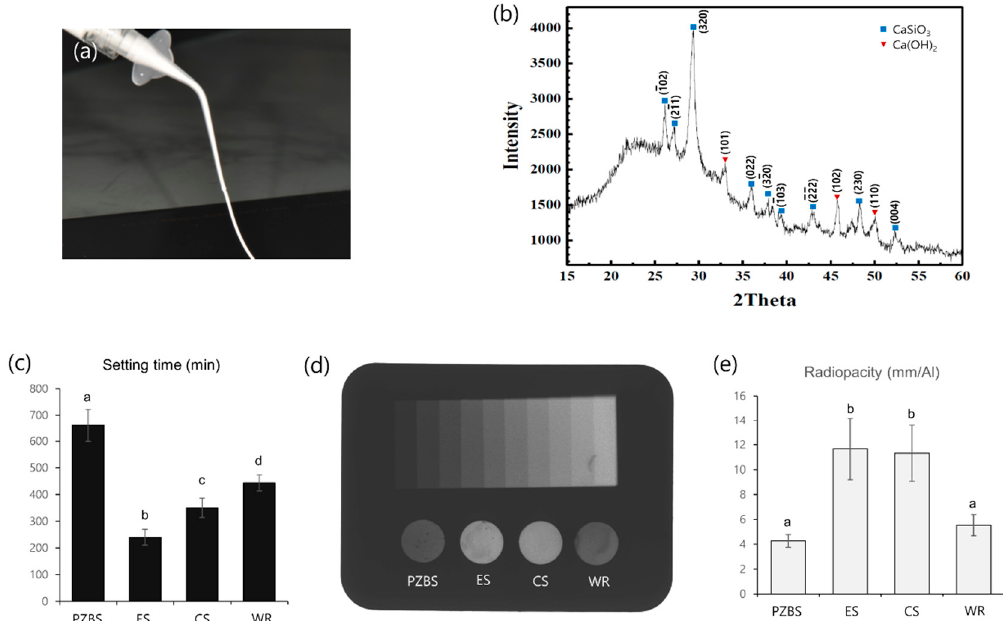
Figure 1. Physical properties of the tested materials: ( a ) The injectable PZBS sealer used in this study. ( b ) X-ray diffraction patterns of PZBS. The hkl index was indicated on the peak. ( c ) The initial setting time of the tested materials. abcd Different letters represent significant differences between the different materials ( p < 0.05). ( d ) Radiograph showing the radiopacity of each material and its equivalence to that of the aluminum step wedge. ( e ) Relative radiographic density of each material in comparison with that of a 10-step aluminum step wedge. ab Different letters represent significant differences between the different materials ( p < 0.05) PZBS: pozzolan-based bioceramic sealer, ES: EndosealTCS, CS: Ceraseal, WR: Well-Root.